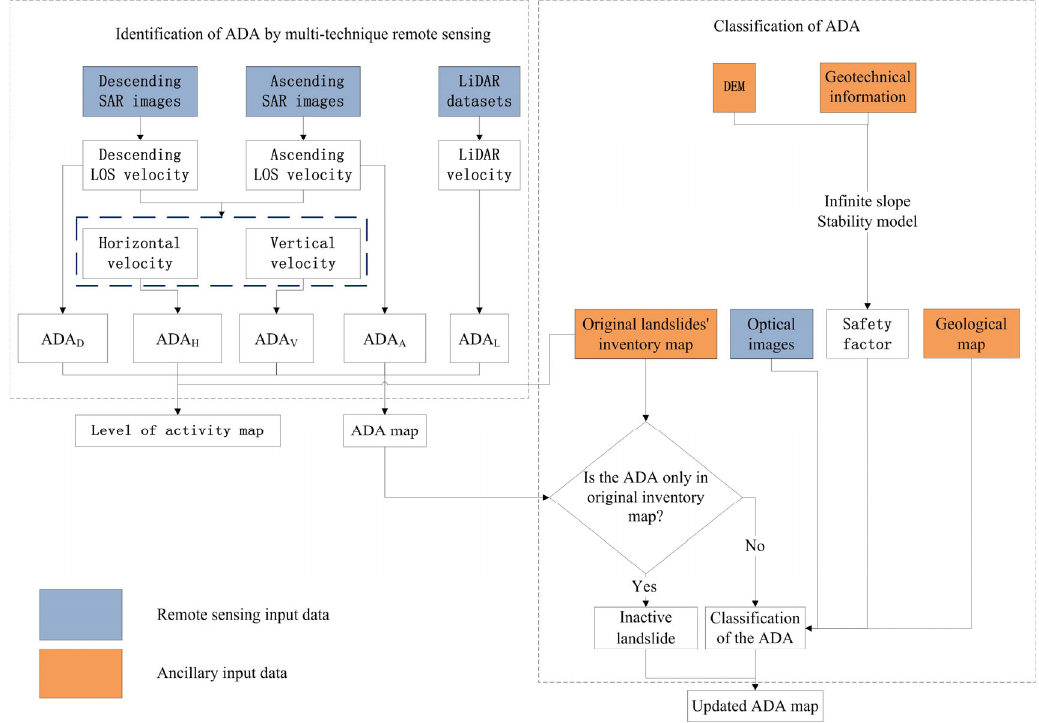
Figure 2. Flowchart of the proposed methodology.